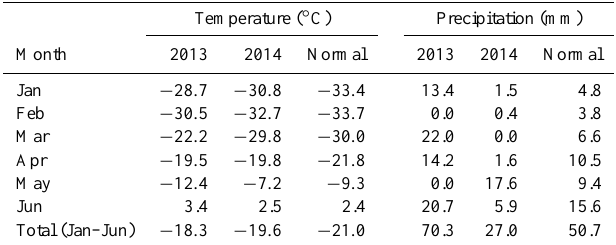
Table B1. Temperature and total precipitation data for the 6months preceding the sampling period in July 2013 and 2014. The climate normal (1981–2010) is also indicated (Environment Canada, 2015).